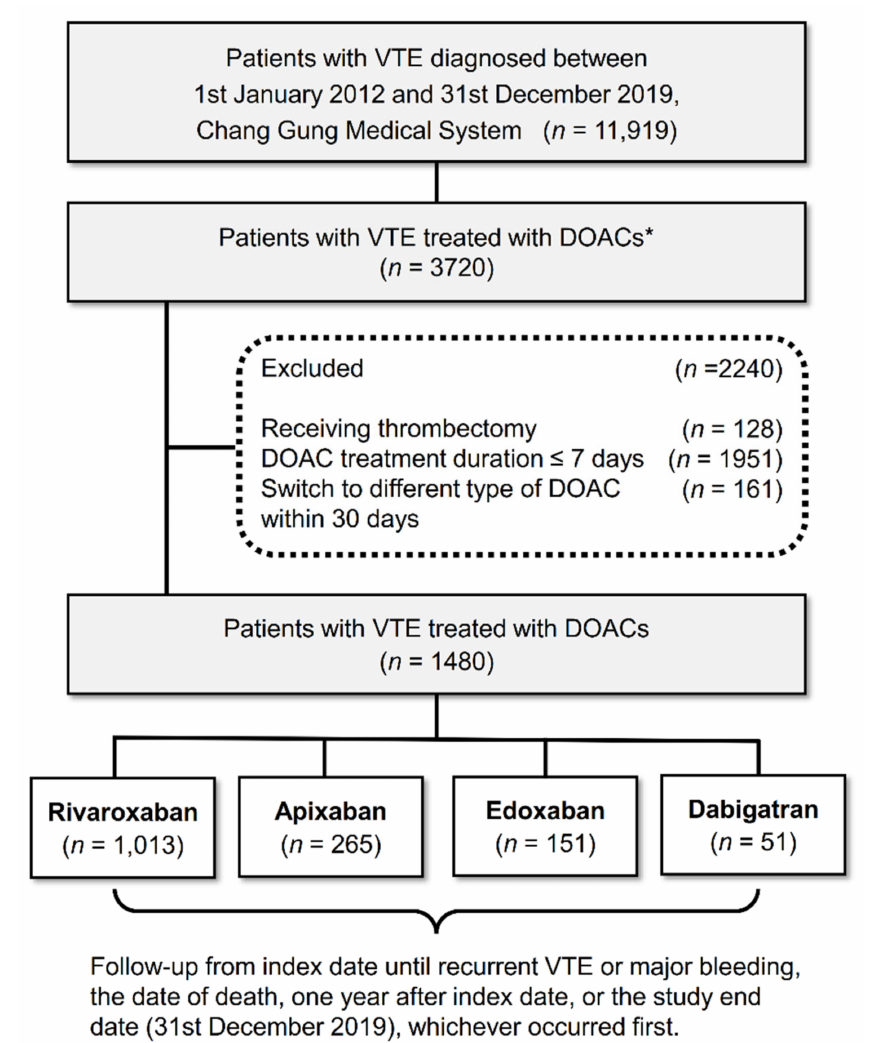
Figure 1. Enrollment and follow-up of study patients. A total of 11,919 patients with newly diagnosed VTE from January 2012 to December 2019 were identified. After relevant exclusion, 1480 patients treated with DOACs were included in the study; of whom, 1013 (68.4%), 265 (18%), 151 (10.2%), and 51 (3.4%) received rivaroxaban, apixaban, edoxaban, and dabigatran, respectively. Those initiated on an anticoagulant therapy for more than 3 months after VTE diagnosis were not included. DOAC, direct oral anticoagulant; VTE, venous thromboembolism. * Those who started anticoagulation therapy more than three months after VTE diagnosis will not be